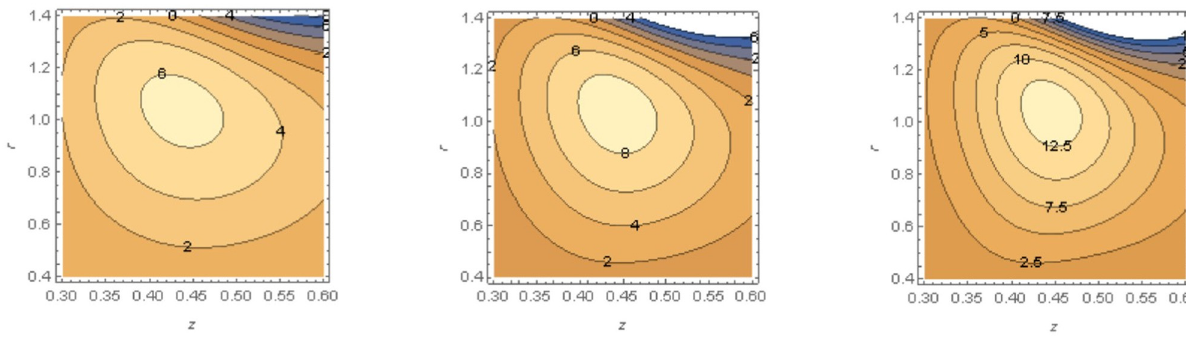
Figure 17: Various values of the wave frame streamlines of W e = { 0.010, 0.015, 0.020 } at ϵ 0.15 =